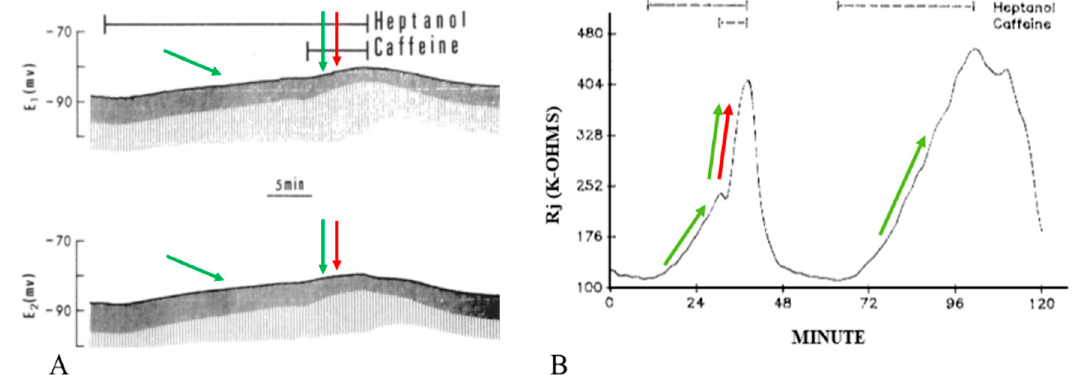
Figure 3. Time course of changes in electrotonic potentials ( A ) and Rj ( B ) in axons uncoupled with heptanol in the presence and absence of 20 mM caffeine. Addition of caffeine to heptanol causes a rapid change in the amplitude of the electrotonic potentials ( A ), indicative of rapid increase in Rj ( B ). Rj increases with heptanol–caffeine 2–3 times as much as with heptanol alone ( B , red arrow). The second heptanol treatment shows that the maximal rate of Rj rise with heptanol alone is 14 k Ω /min ( B , green arrow), while with heptanol–caffeine (first treatment) the rate more than doubles (35 k Ω /min) ( B , red and green arrows). Note that the membrane depolarization caused by heptanol (( A ), left green arrow) is increased by caffeine addition ( A , red and green arrows). The maximum depolarization ( A ) corresponds to the maximum Rj increase ( B ). Adapted from [16].